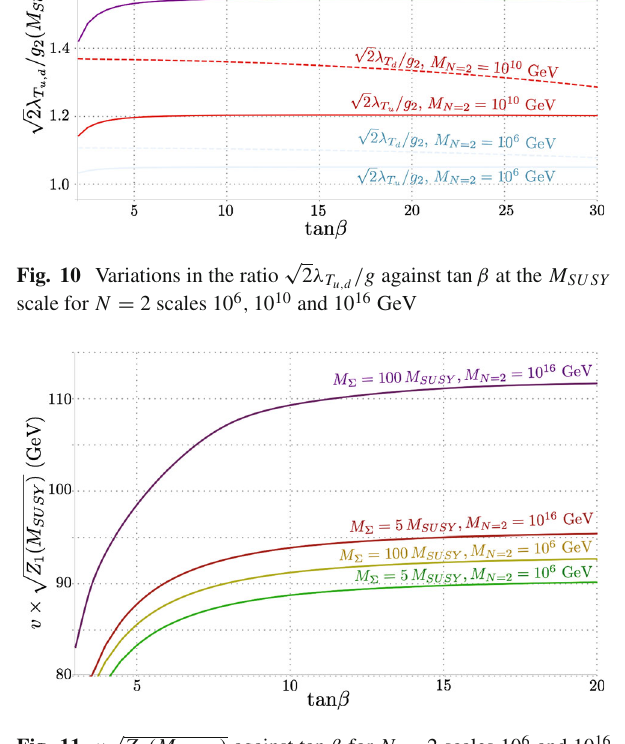
Fig. 13 M SUSY against tan β for a Higgs mass of 125 GeV at m t and where Q = 600 GeV, plotted for values of M (cid:12) = 5, 100 M SUSY and M N = 2 = 10 6 and 10 16